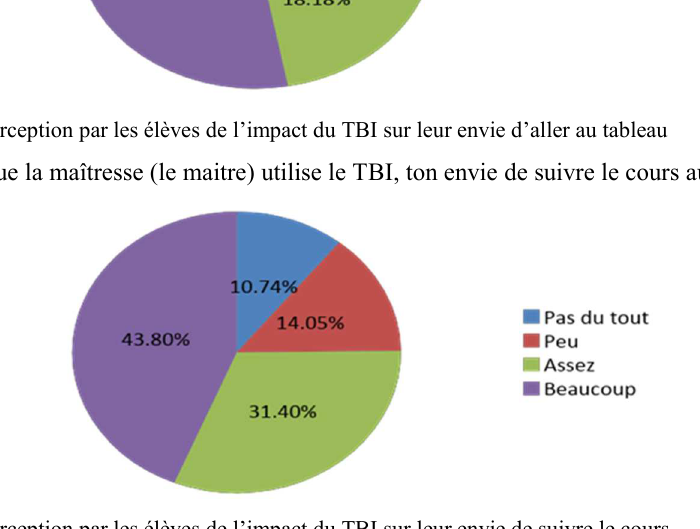
Fig. 2 La perception par les élèves de l’impact du TBI sur leur envie de suivre le